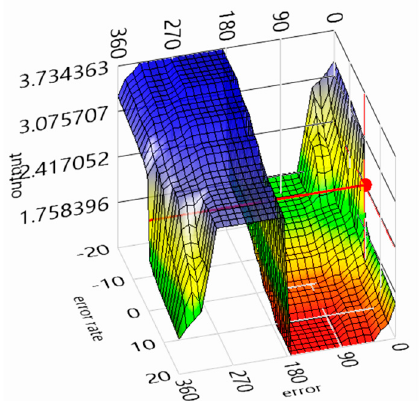
Figure 5. Heading output surfaces of the FLC. The horizontal axis is the heading error. The vertical axis is the heading error rate. The Z-axis is the output value of the FLC.